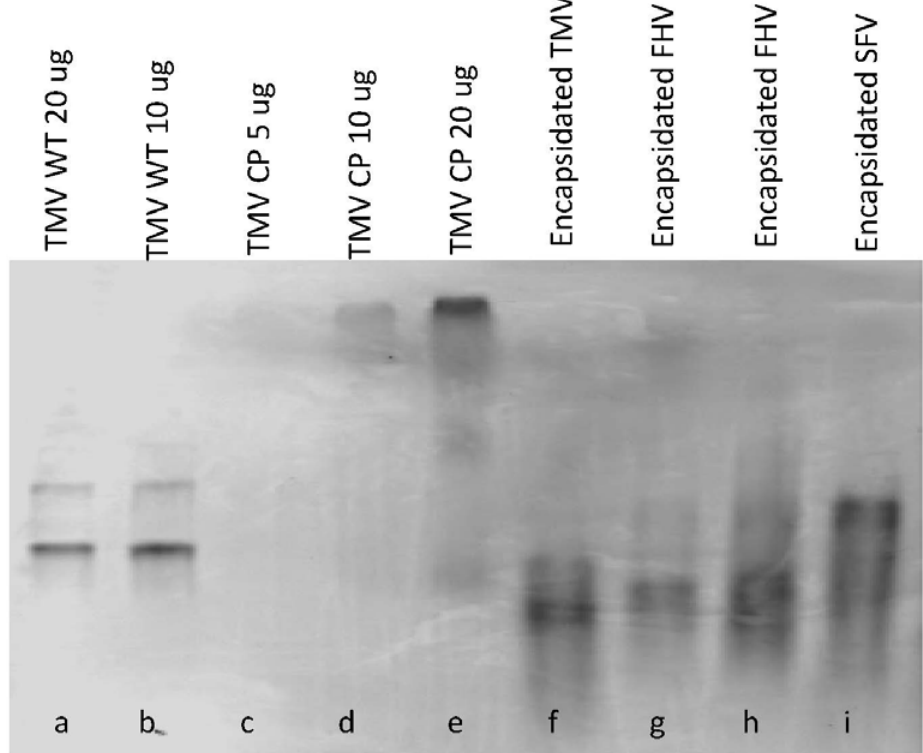
Figure 6. Characterization of in vitro encapsidated products by comparing migration rates on a Coomassie-stained 0.5% w / v agarose gel. TMV CP was mixed with OA-containing RNAs in the presence of a 25 mM phosphate buffer and incubated overnight at room temperature. The resulting mixture was polyethelene glycol (PEG) precipitated, pelleted and resuspended with 50 µL nuclease free PBS. 20 µg of encapsidated product was loaded onto a 0.5% Tris-phosphate-EDTA (TPE) gel and electrophoresis was performed at 300 mA for 3 h. The gel was stained with Coomassie blue overnight and de-stained for 2 days. TMV wild type virus and TMV CP were run as a control and size markers where the TMV WT monomer runs at 6 kb and dimer runs at 12 kb: ( a ) TMV WT 20 µg; ( b ) TMV WT 10 µg; ( c ) TMV CP 5